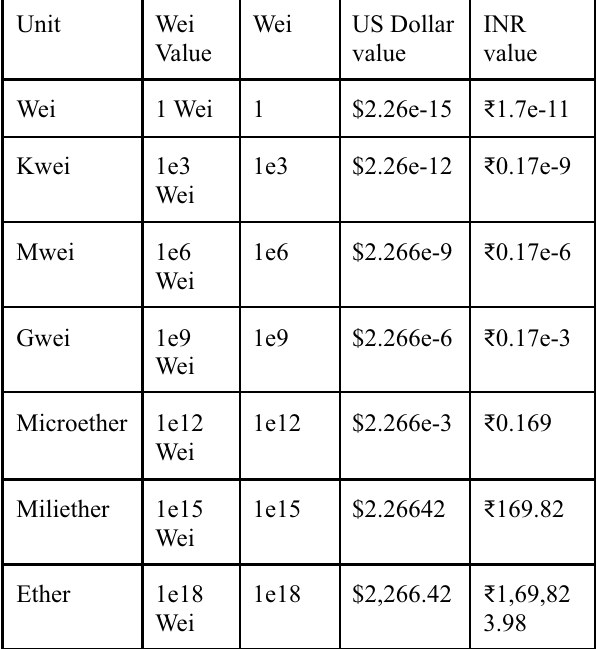
Table 1. Denomination of ethers converted into US Dollars and Indian Rupees (Accurate as of 24 April